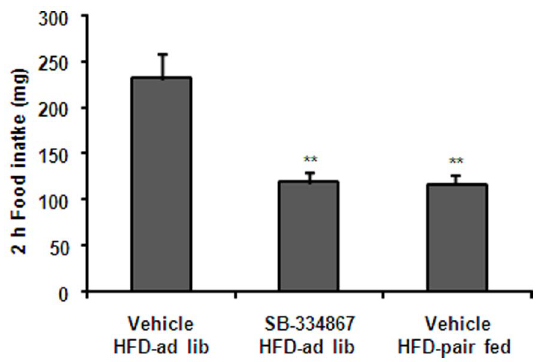
Figure 6. Orexin signaling blockade reduces spontaneous consumption of HFD. Figure shows 2 h food intake in mice of vehicle-HFD- ad lib , SB334867-HFD- ad lib and vehicle-HFD-pair-fed groups. Values are the mean 6 SEM. **, p , 0.01 vs. vehicle HDF- ad lib